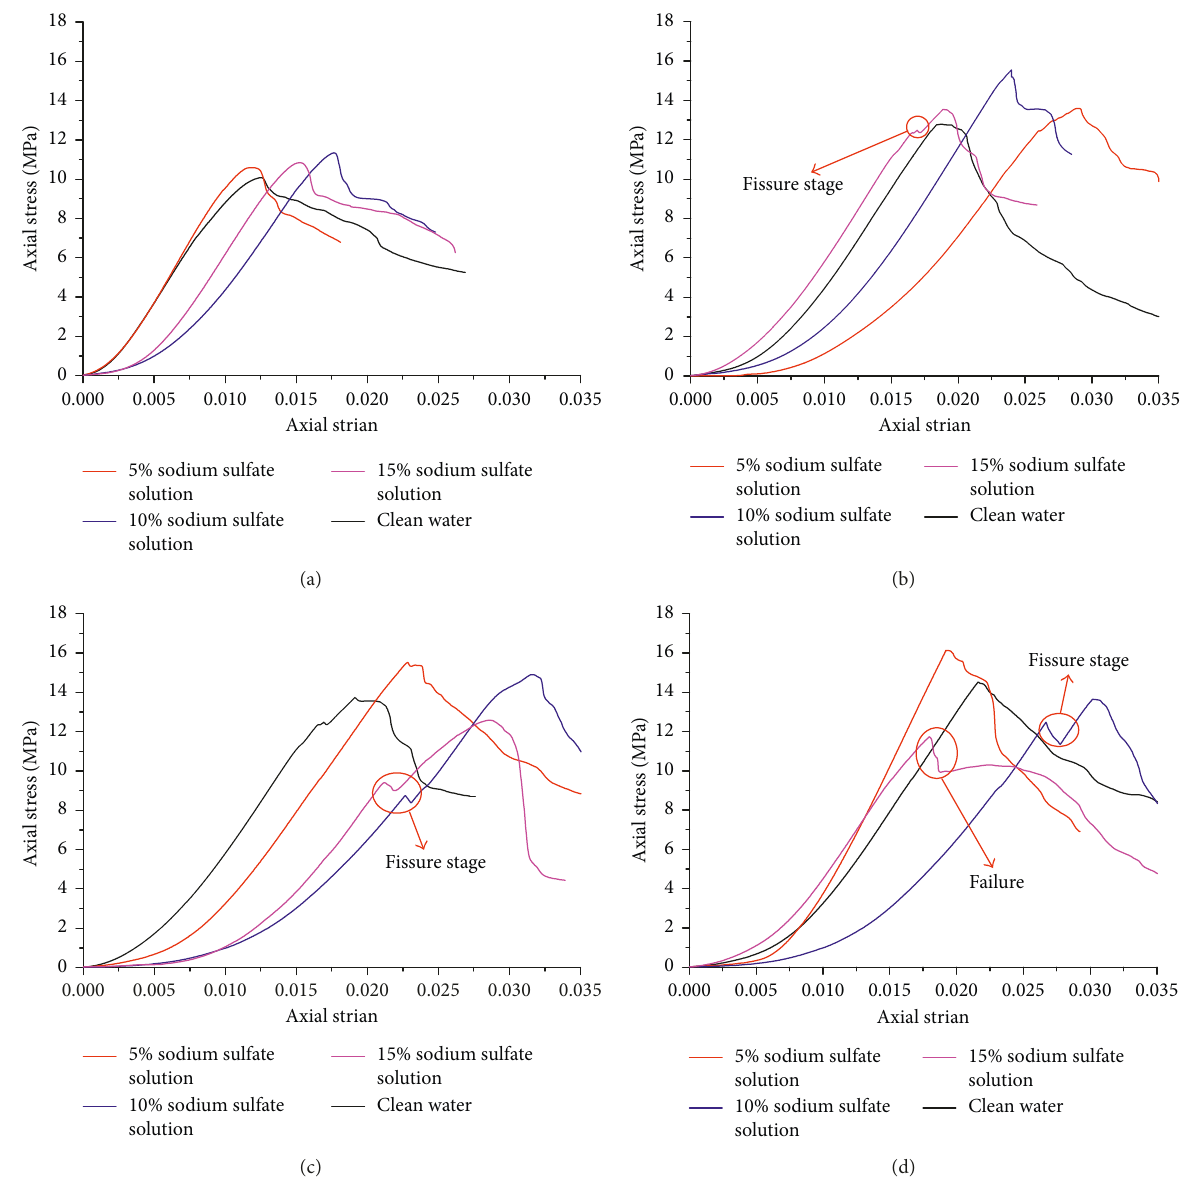
Figure 5: Stress-strain curves of each group for each soaking period: (a) 30d; (b) 60d; (c) 90 d; (d)